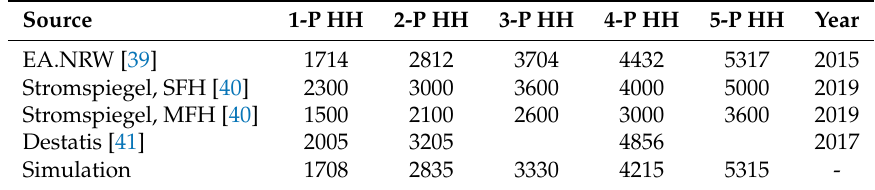
Table 7. Energy consumption per household in Germany in literature and